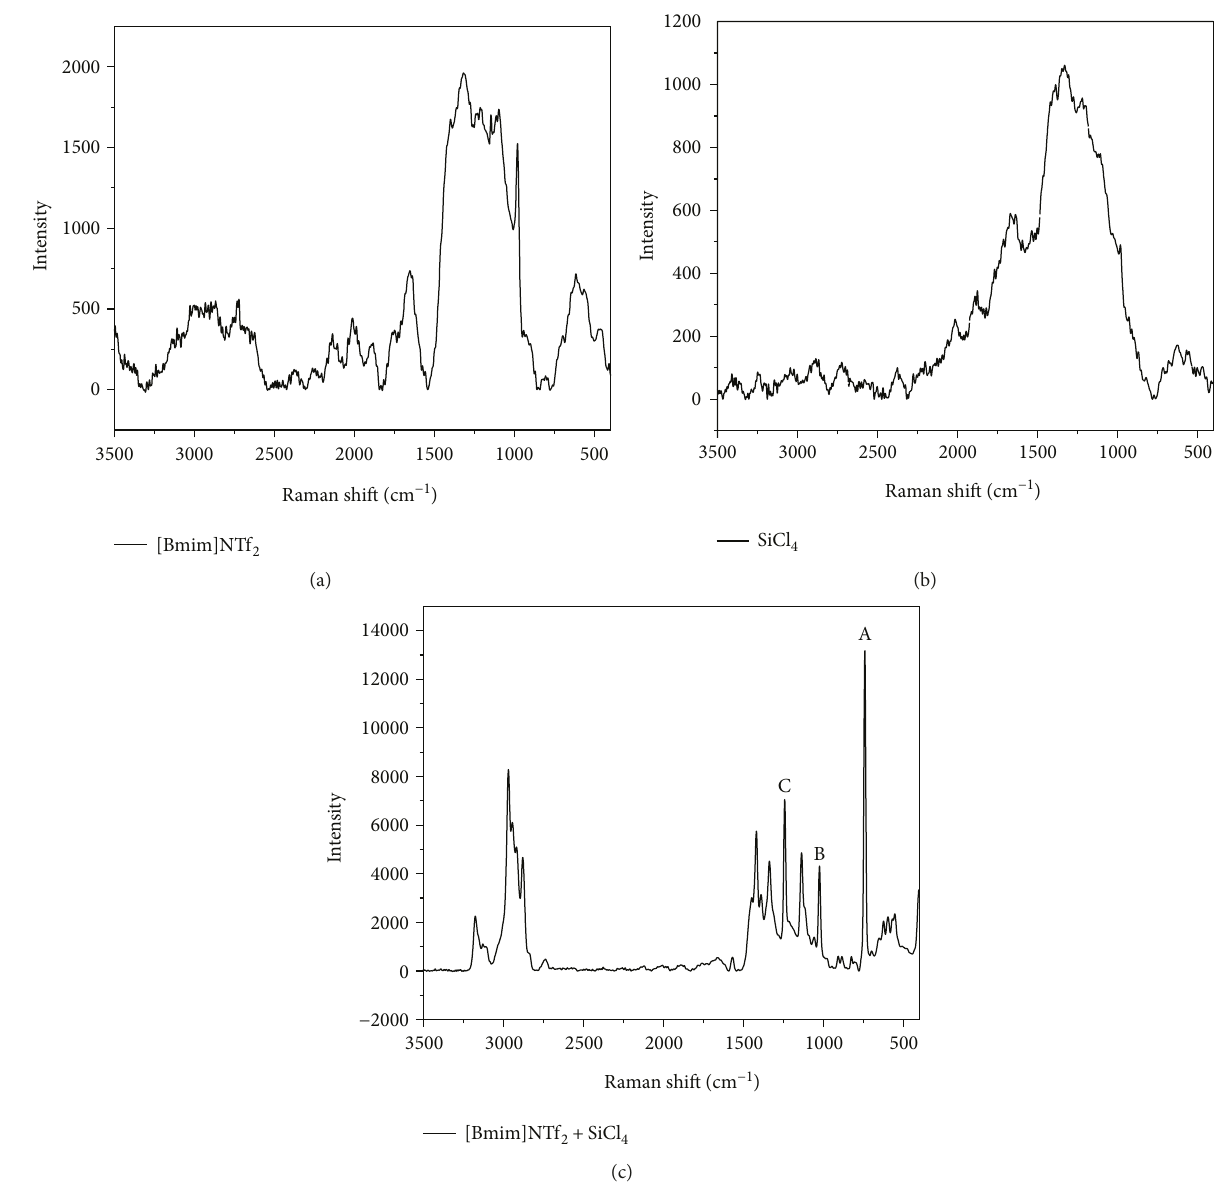
Figure 3: Raman spectra of the original ILs and the ILs dissolved SiCl